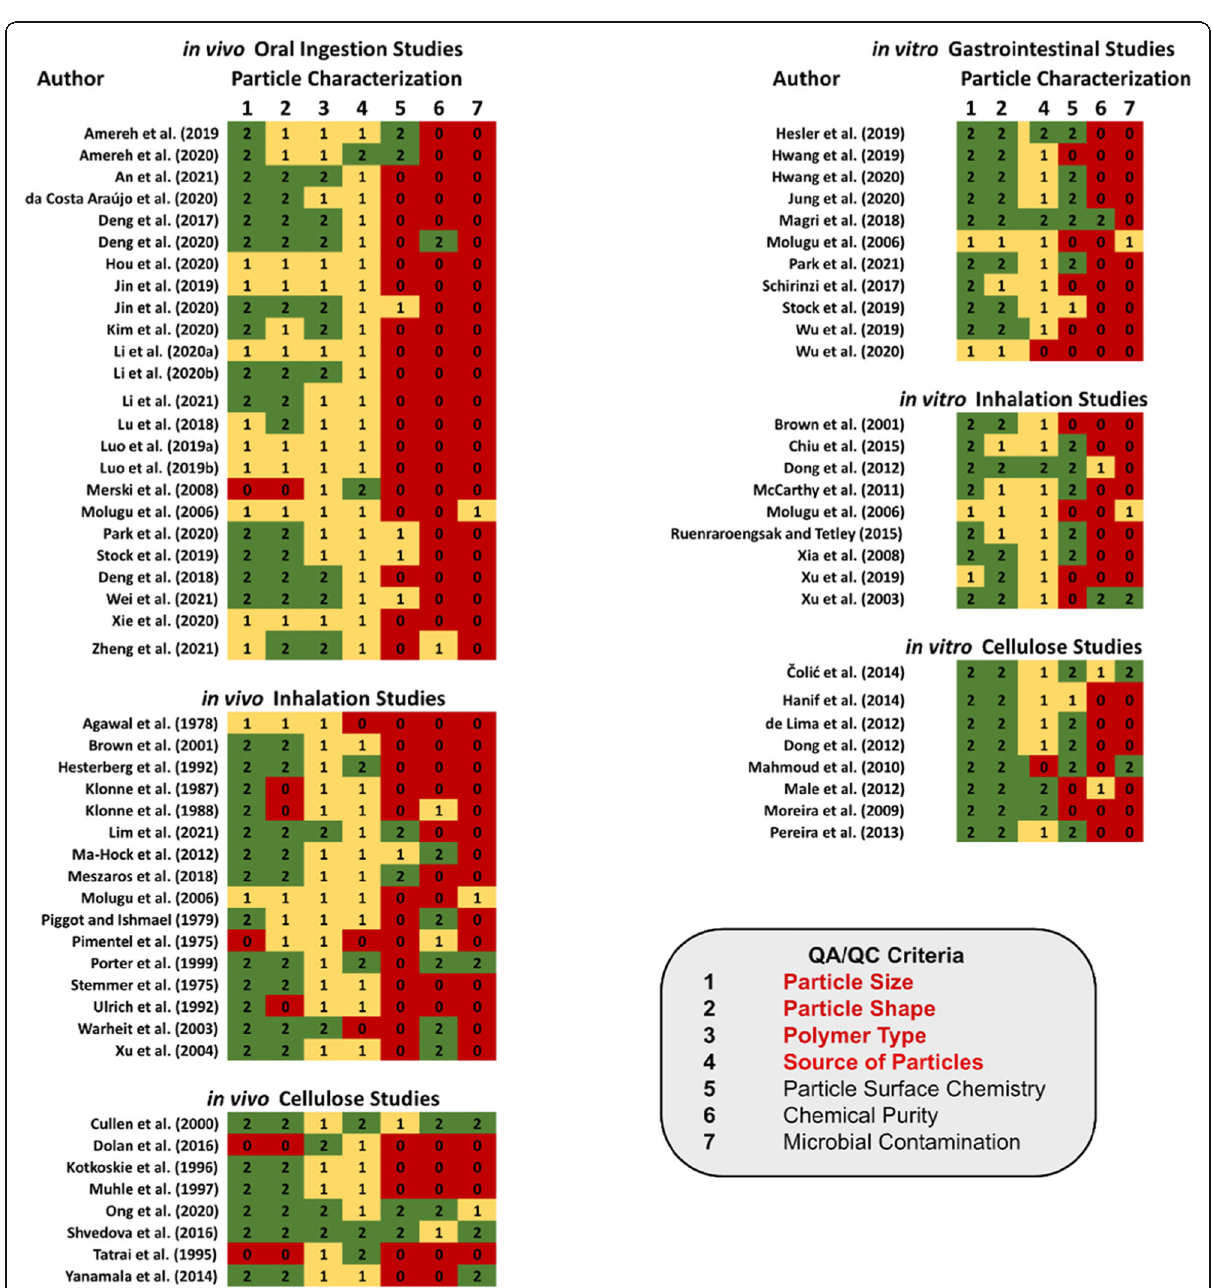
Fig. 2 Summary of evaluation scores for QA/QC criteria aligned with the reporting of particle characterization components of studies assessed by the NMP-TSAT. Please note that some studies report results for both in vitro and in vivo toxicity effects, such as Brown et al. [82], Molugu et al. [72], and Stock et al.